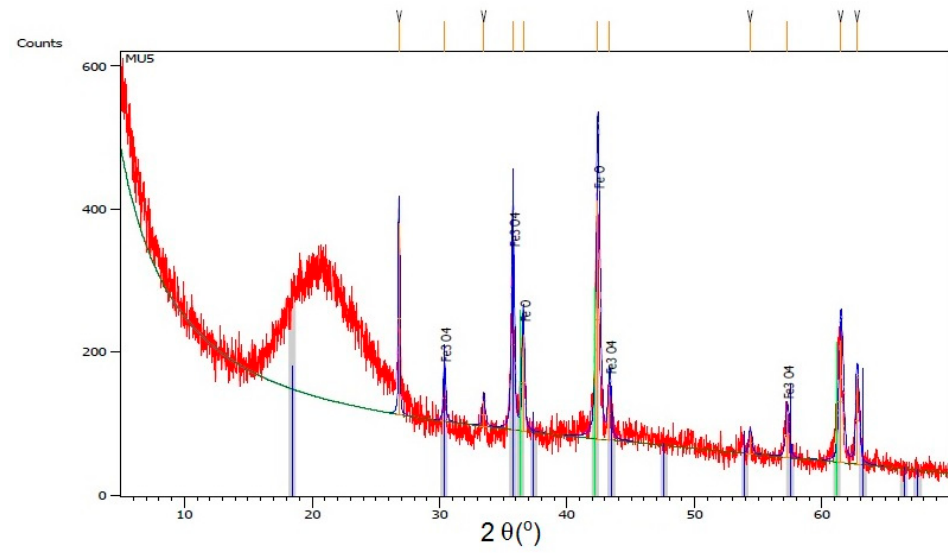
Figure 6. Isolated signals for mFe 3 O 4 on the example of XRD diffractogram for the MU5 composite.